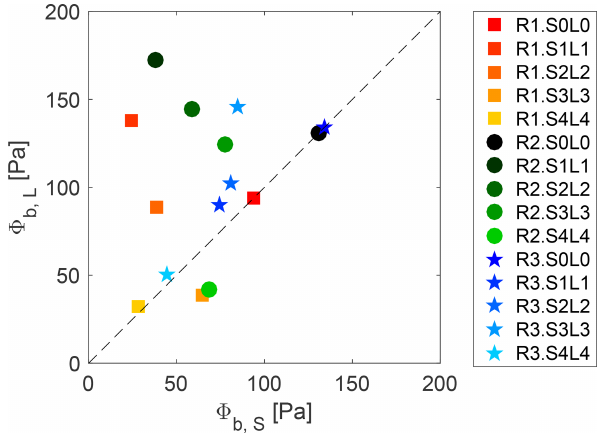
Figure 12. Comparison of the bottom erosion capacity (cid:56) b between tests with lock slope ( S i ) and correspondent tests on a horizontal bottom ( L i ). The dashed line is the identity line.